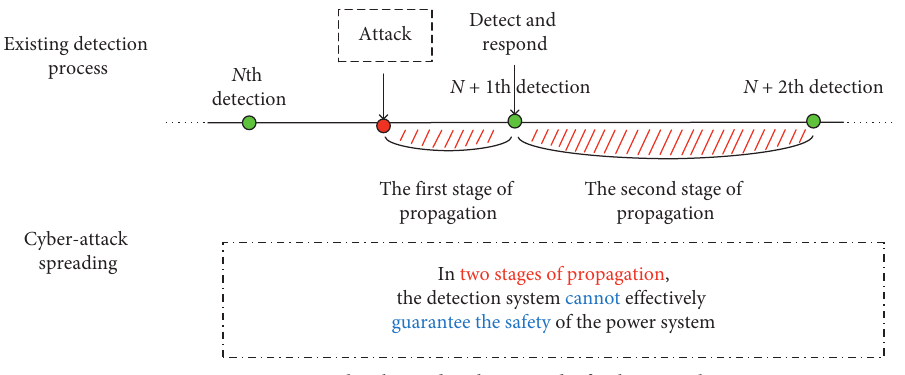
Figure 1: Potential risks under the spread of